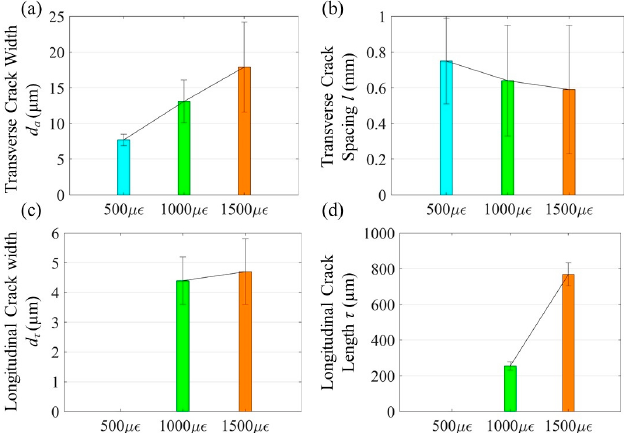
Figure 8. Strain dependence of: transverse crack ( a ) width and ( b ) spacing, longitudinal crack ( c ) width and ( d ) length.